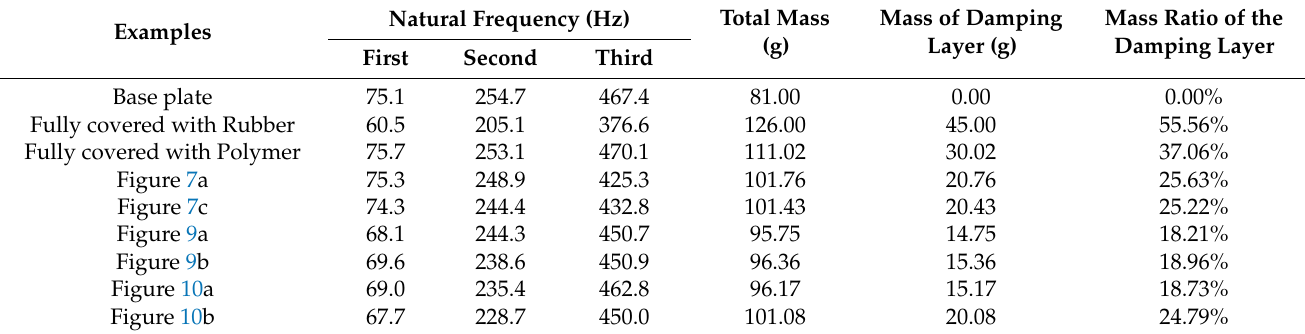
Table 3. Dynamic stiffness and mass comparison of different